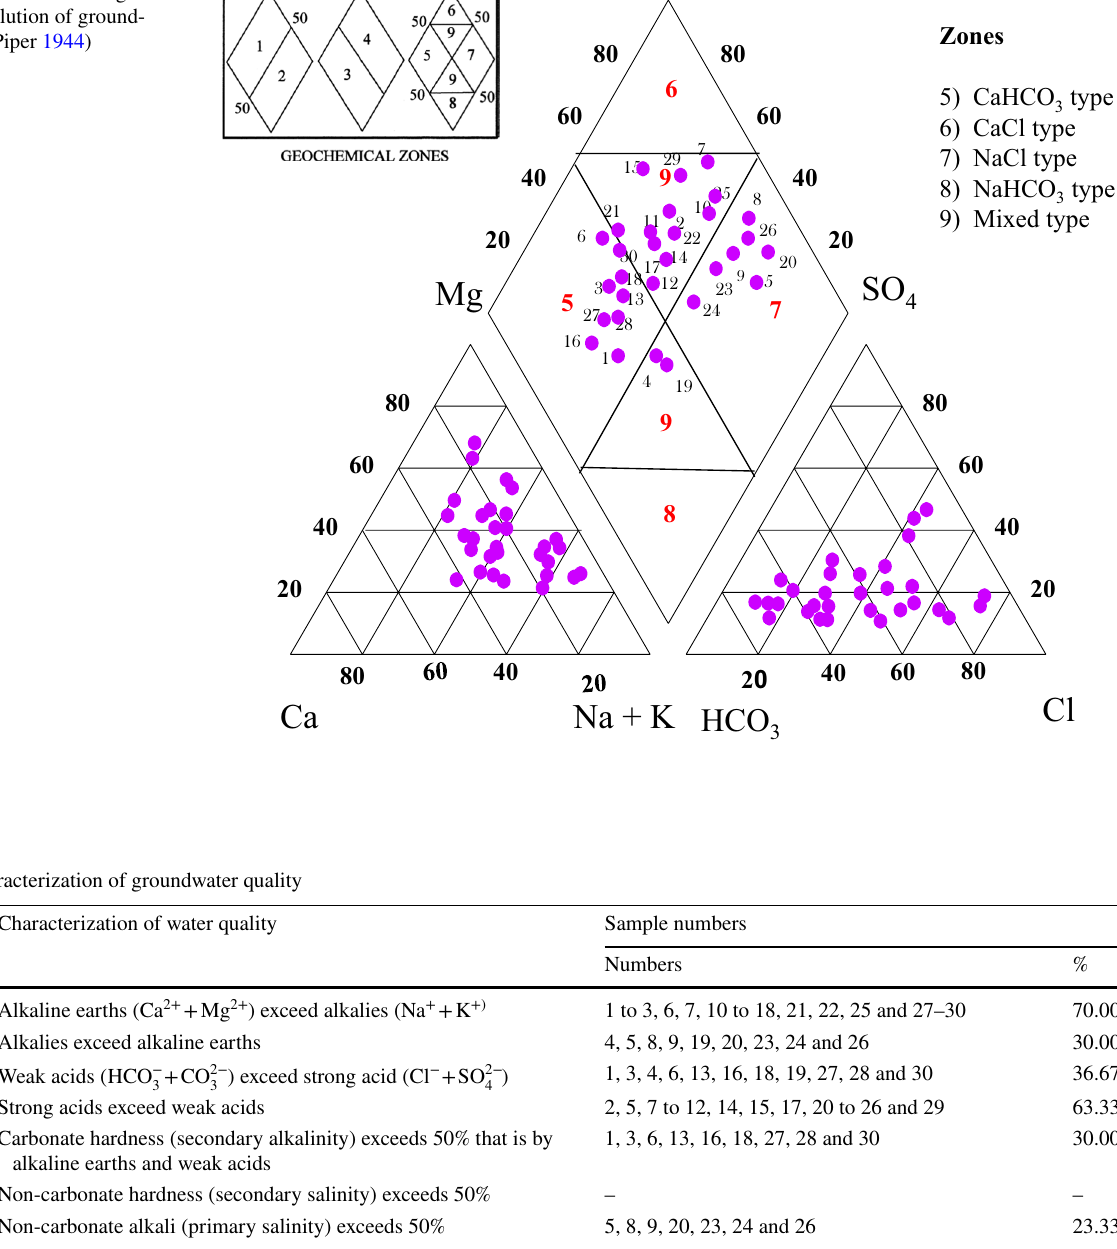
Fig. 6 Characterization of geo- chemical evolution of ground- water (after Piper